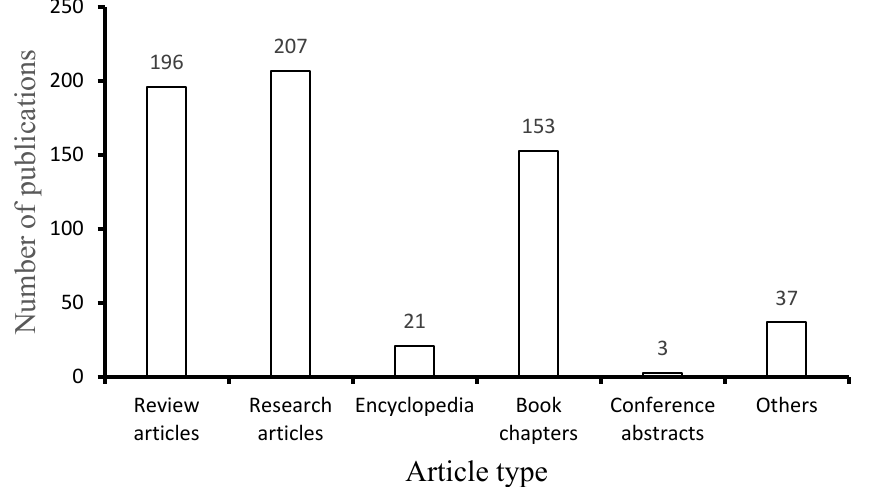
Figure 8. Science direct search engine for nanocellulose crystal-based membranes for wastewater treatment (data extracted from www.sciencedirect.com on 14 July 2021 from Science direct, using the keywords “nanocellulose crystal”, “membranes”, “wastewater”, and “treatment”).